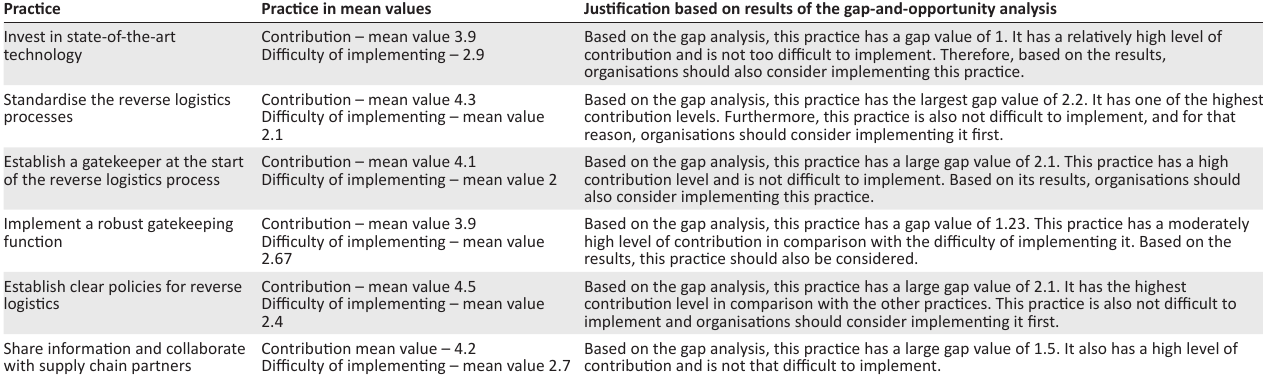
TABLE 3: Reverse logistics practices in the Pearl quadrant – first